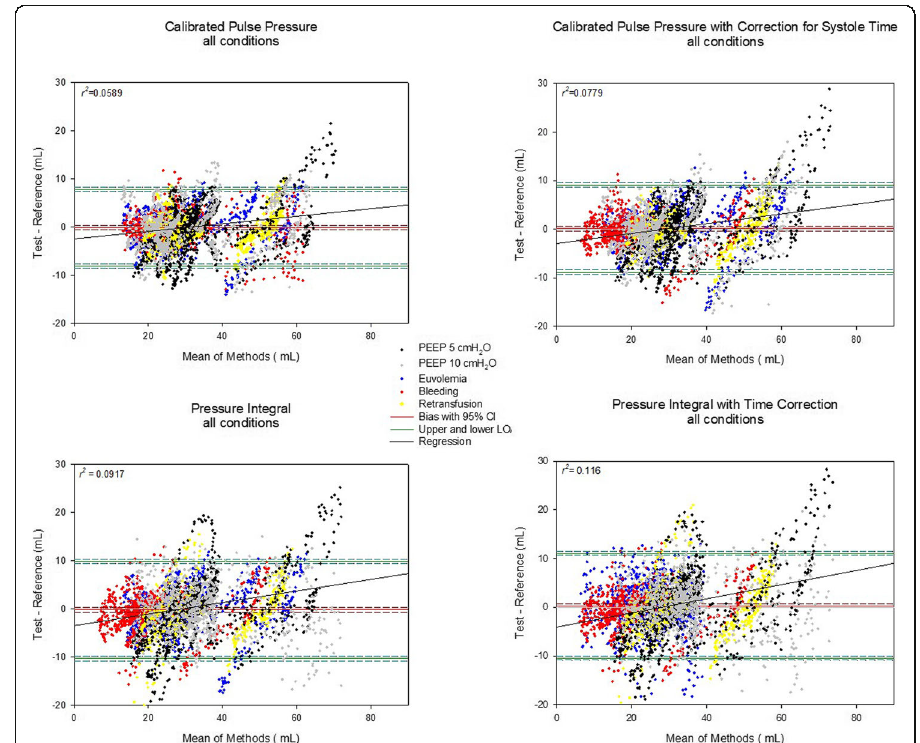
Fig. 1 Bland-Altman plots for the four methods and all experimental steps. One hundred stroke volumes per animal and experimental condition are displayed, adding up to a total of 4300 beats. The experimental conditions are differentiated according to the color code in the legend (black cross, PEEP 5 cmH 2 O; grey cross, PEEP 10 cmH 2 O; blue cross, baseline; red cross, bleeding; yellow cross,